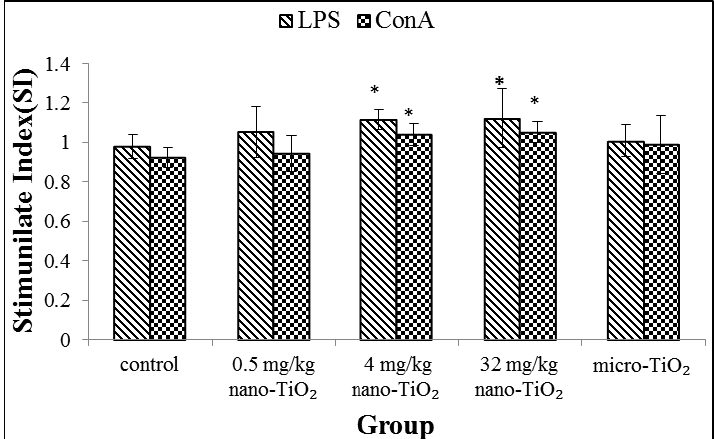
Figure 2. Lymphocyte proliferation in the spleen from rats exposed to nano-TiO 28 days by intratracheal instillation. * represents significantly different from control group ( p < 0.05).